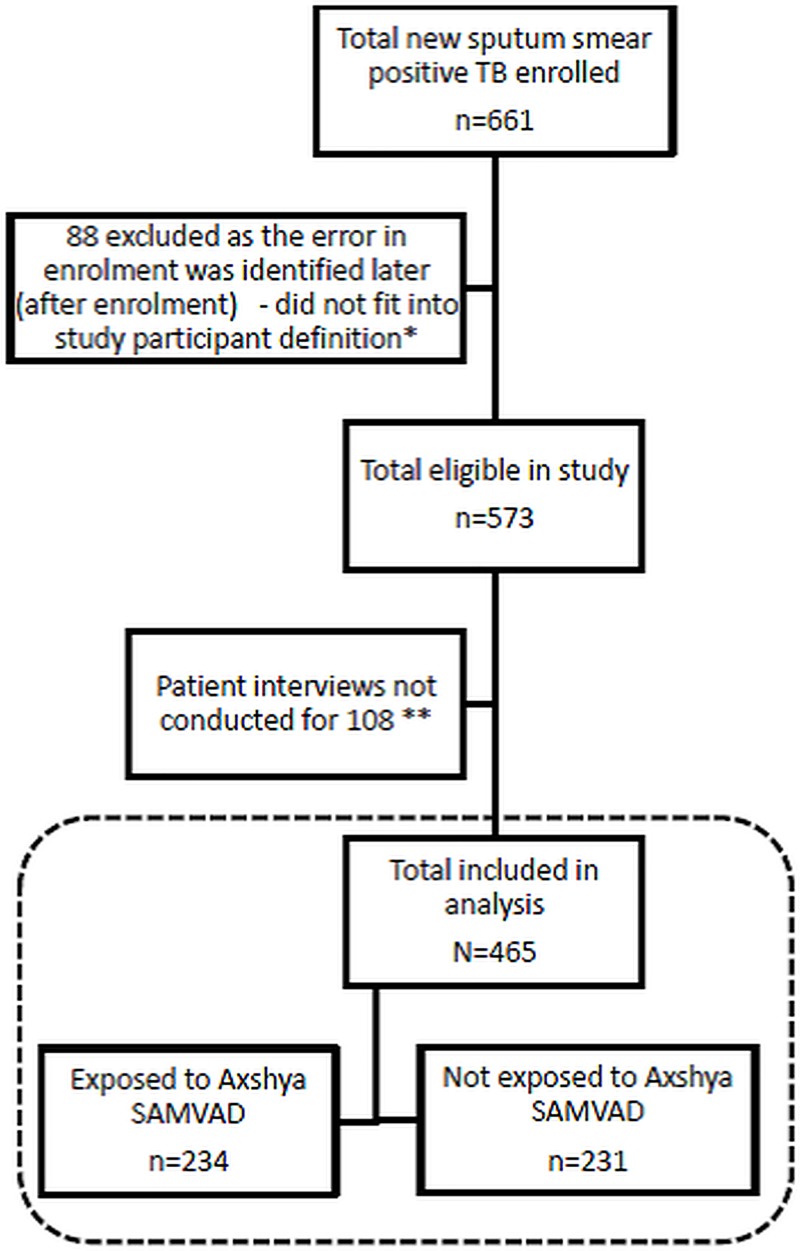
Flow chart depicting study participant enrolment in Axshya SAMVAD study across 18 randomly sampled districts in India (2016–2017).SAMVAD–sensitization and advocacy in marginalised and vulnerable areas of the district. Axshya SAMVAD–an active case finding strategy under project Axshya implemented by The Union, South East Asia office, New Delhi, India, across 285 districts of India. *32 were due to errors during record review (either patient turned out to be previously treated or sputum smear negative TB; 56 patients were recorded as new patients but turned out to be previously treated during patient interviews. ** due to patient non-availability during visit to residence.